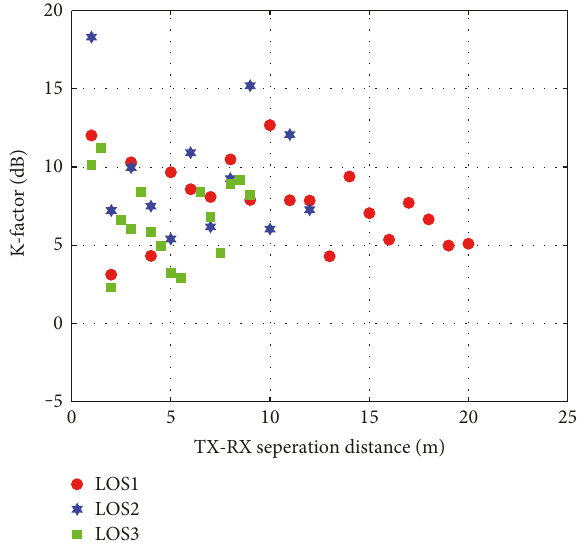
Figure 7: Ricean K-factor variation with TX-RX separation distance in LOS tunnel scenarios.